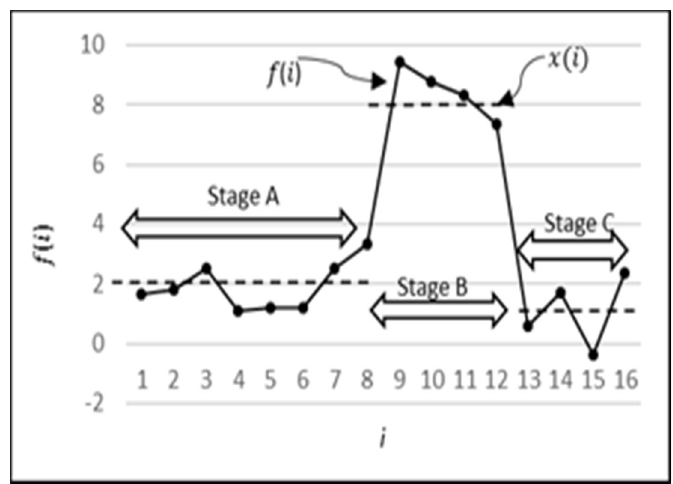
Figure 6. Details of the pattern created in synthetic data.